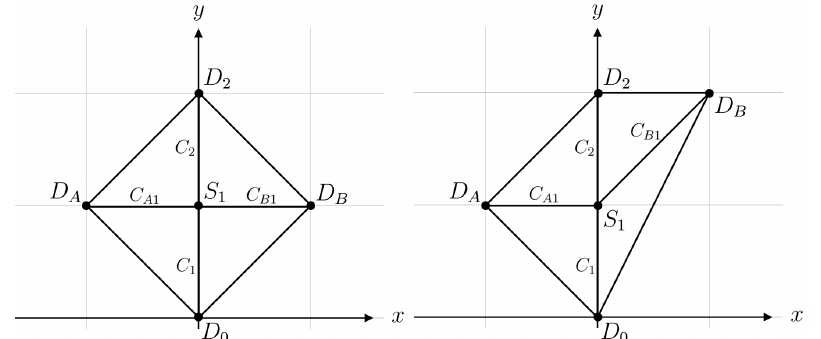
Figure 3 . The toric diagrams for SU(2) 0 (left) and SU(2) π (right) theories. Note how the diagrams have the same general shape as SU( N ) of figure 1. This can be traced to the fact that the discrete k theta angle for n = 2 is essentially the same thing as k mod 2 since the relevant eta invariant takes discrete